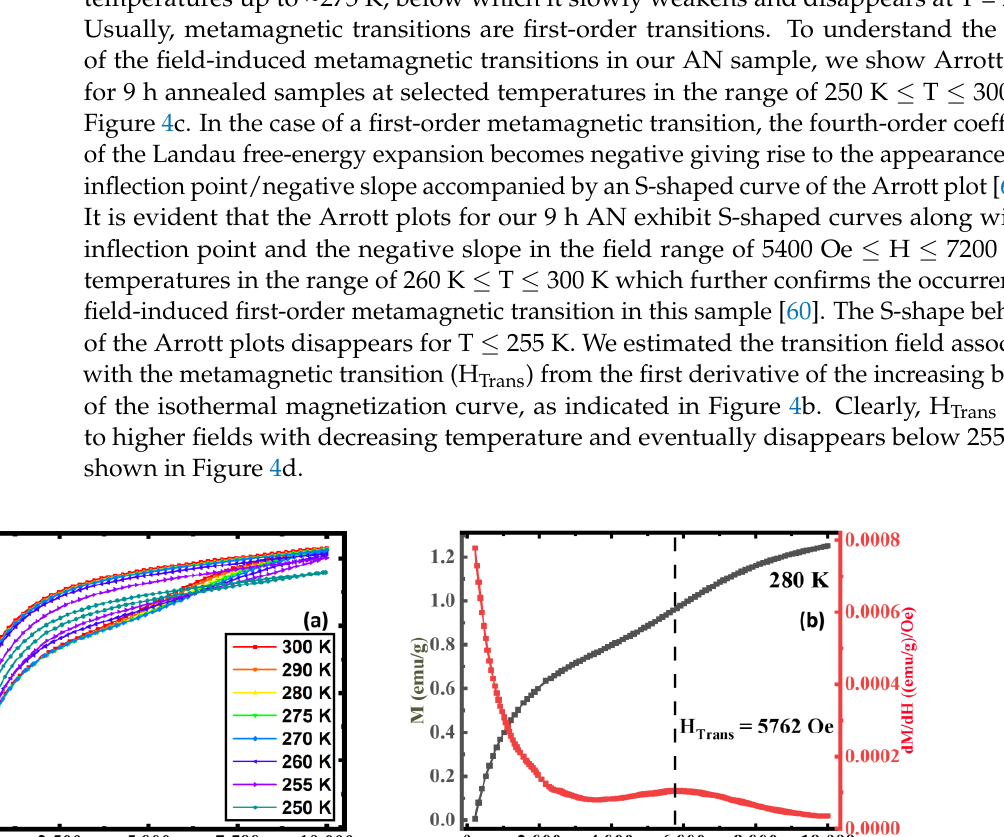
Figure 4. ( a ) Magnetic hysteresis loops M(H) between 250 K and 300 K, ( b ) magnetization curve and the change in magnetization with respect to field vs. field curve at 280 K, ( c ) Arrott plots between 250 K and 300 K, and ( d ) the transition field (H Trans ) vs. temperature of the 9 h annealed sample. In Figure 5, we show the isothermal M(H) loops for all the samples at T = 10 K measured under zero-field cooled (ZFC) and field-cooled (FC) protocols with the cooling field of µ 0 H = 1 T. Under ZFC protocol, the sample was first cooled down to 10 K from 300 K in zero field, and the M(H) data were then taken at 10 K. On the other hand, under FC protocol a 1 T field was applied to the sample while cooling it down from 300 K to 10 K, and the M(H) loop was measured at 10 K. It is evident that the magnetization value at the highest applied magnetic field (1 T) remains the same for ZFC and FC M(H) loops for all the samples. Interestingly, the FC M(H) shows an enhancement magnetization in the low field region (below ~5 kOe) for all the samples in comparison to the ZFC M(H) except for the 1 h AN sample for which the aforementioned low field enhancement is comparatively smaller than the other samples. Furthermore, the enhancement in the low field magnetization